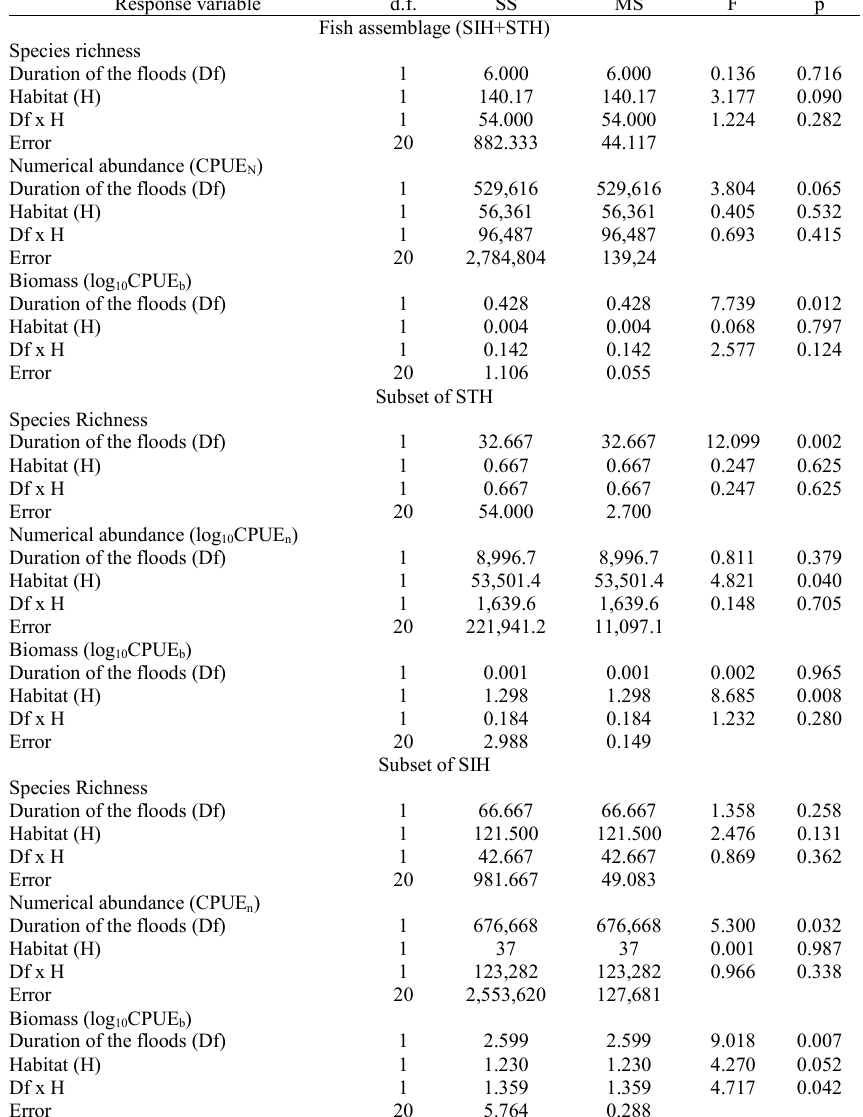
Table 2. Results of the ANOVAs that examined the main effects (duration of the floods and habitat) on the fish